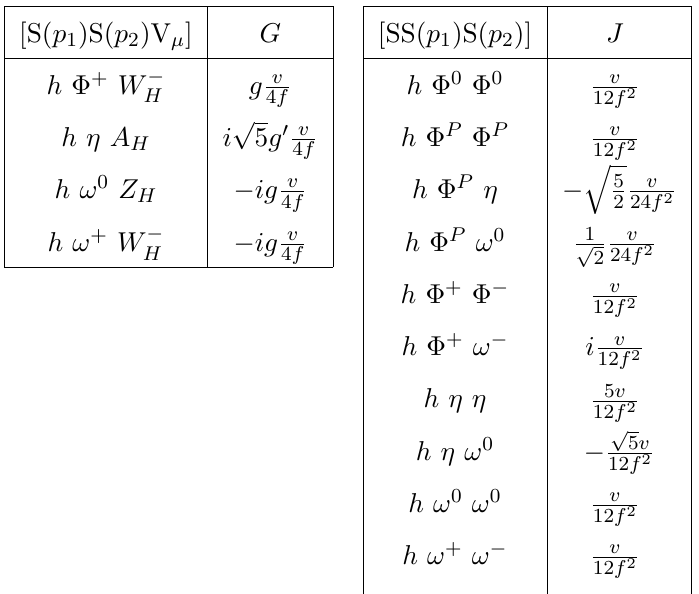
Table 5 . Scalar-Scalar-Vector and Scalar-Scalar-Scalar couplings at O ( v 2 =f 2 ). Other combinations also involving h